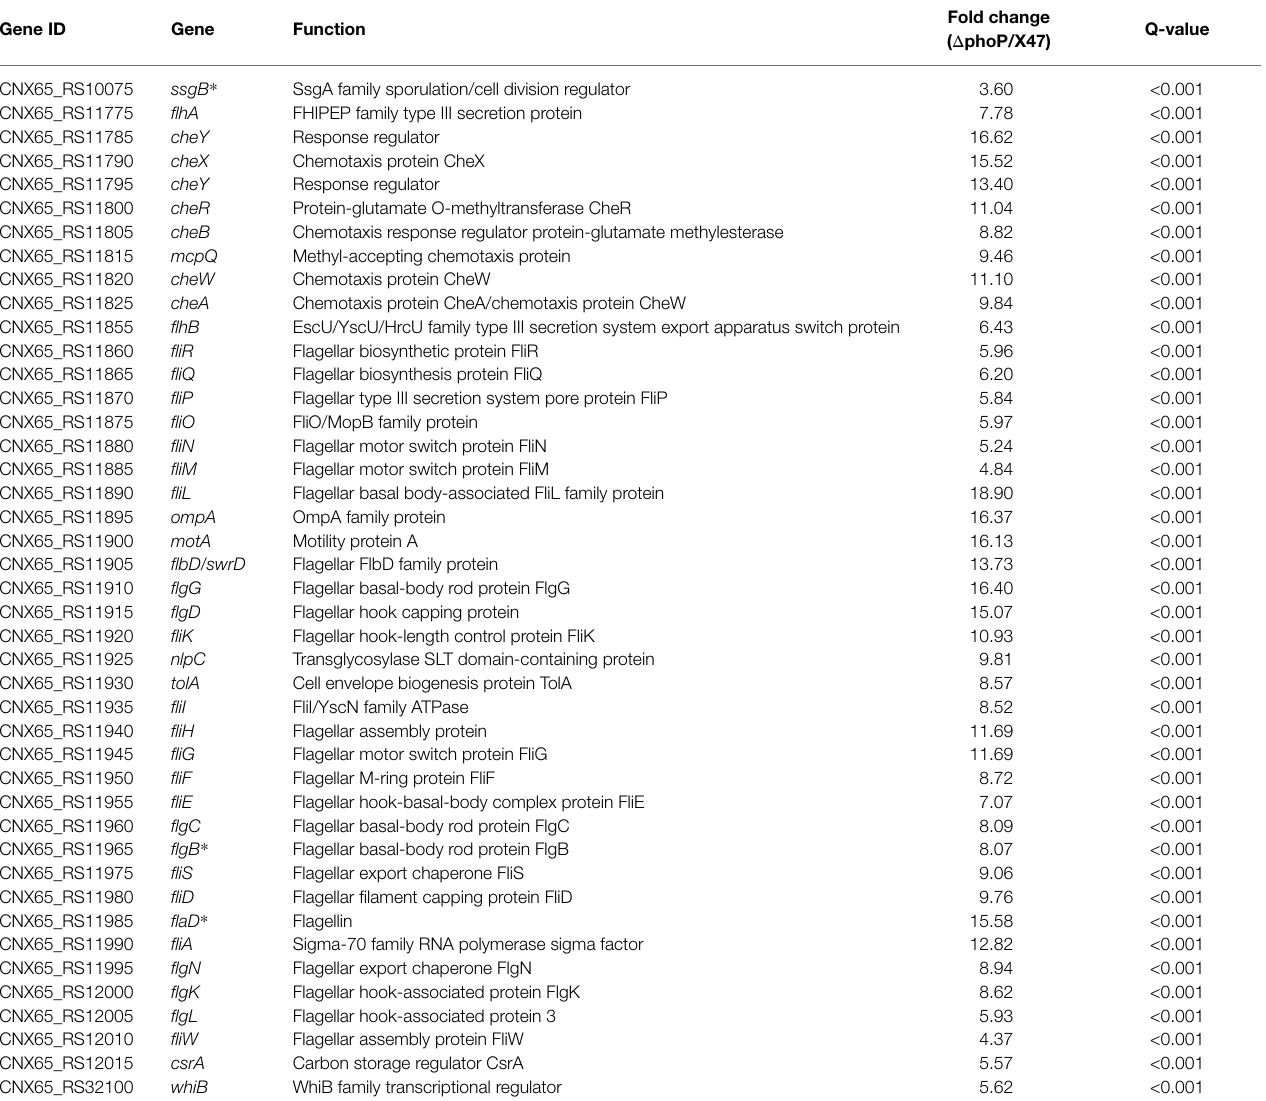
TABLE 1 | PhoP deletion alters the expression of developmental and chemotaxis-related genes in A. pretiosum . Gene